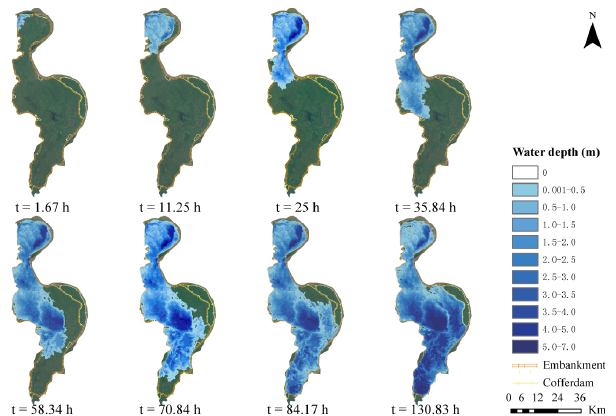
Fig. 8. Filled contours plot of initial and computed water depth given by the present model at time t =1.67, 11.25, 25, 35.84, 58.34, 70.84, 84.17, and